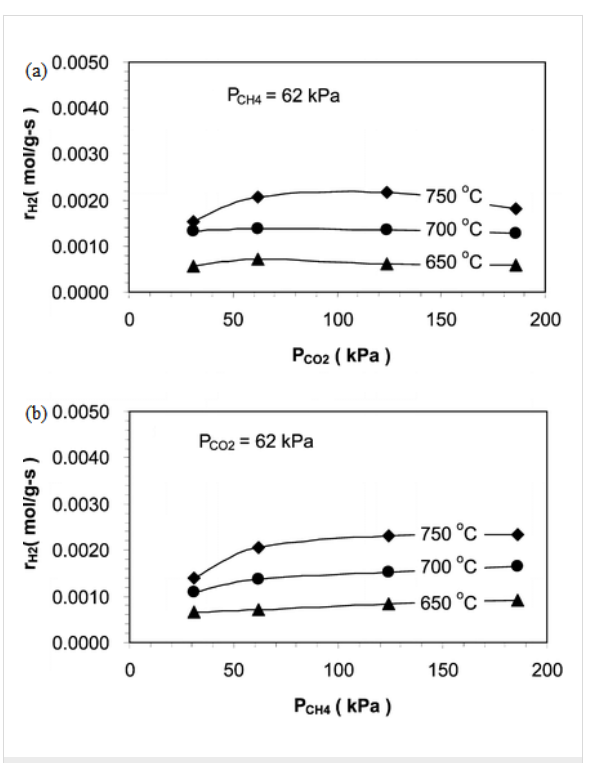
Figure 8: The formation rates of H 2 affected by (a) CH 4 partial pres- sure and (b) CO 2 partial pressure at different temperatures. Reprinted from [86], copyright 2009 American Chemical